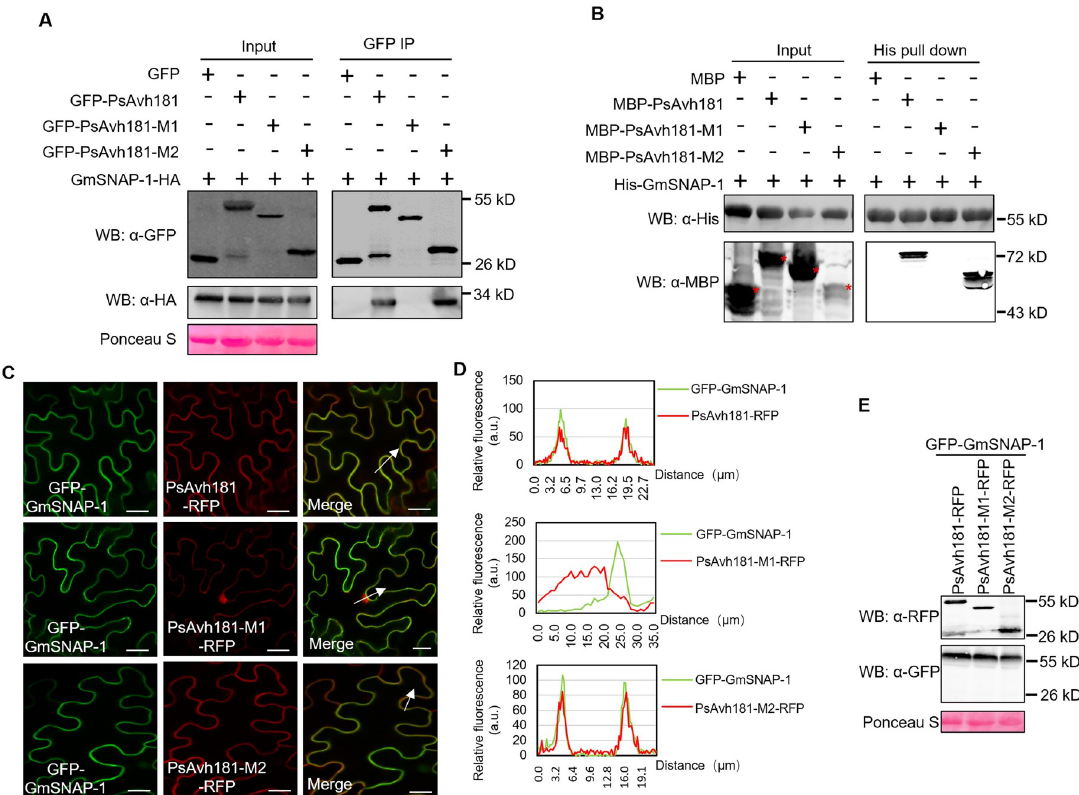
Fig 4. PsAvh181 interacts with soybean SNAP proteins. (A) GmSNAP-1 interacts with PsAvh181, but not with the PsAvh181-M1 mutant (with deletion of the 70–95 amino acids of PsAvh181) in vivo . GmSNAP-1-HA was co-expressed with GFP-PsAvh181, GFP-PsAvh181-M1 or GFP-PsAvh181-M2 in N . benthamiana . Total proteins were purified from N . benthamian a and co- immunoprecipitated with GFP-Trap_A beads. Coprecipitation of GmSNAP-1-HA was detected by western blot analysis. (B) PsAvh181 interacts with GmSNAP in vitro . His-GmSNAP-1, MBP-PsAvh181, MBP-PsAvh181-M1, MBP-PsAvh181-M2 and MBP were expressed in Escherichia coli , with MBP as a negative control. Proteins were mixed as indicated. His-pulldown were performed with Ni-NTA Agarose, and the captured proteins were detected by western blot analysis using anti-His and anti-MBP antibodies. (C) Colocalization of N-terminal GFP-tagged GmSNAP with RFP-tagged PsAvh181 or its mutants. Scale bars, 20 μ m. GFP-GmSNAP-1, was co-expressed with PsAvh181-RFP or a mutant (PsAvh181-M1-RFP or PsAvh181-M2-RFP) in N . benthamiana . Fluorescence from epidermal cells in the infiltrated tissues was detected by confocal microscopy at 48 h post agroinfiltration. (D) Fluorescence analysis of GFP-GmSNAP-1 with PsAvh181-RFP, PsAvh181-M1-RFP or PsAvh181-M2-RFP (white arrowheads). y axis, GFP or RFP relative fluorescence intensity; x axis, transect length ( μ m). (E) Recombinant proteins of GFP-GmSNAP-1 co-expressed with PsAvh181-RFP, PsAvh181-M1-RFP or PsAvh181-M2-RFP were detected in the N . benthamiana leaves by western blotting using anti-GFP and anti-RFP antibodies.